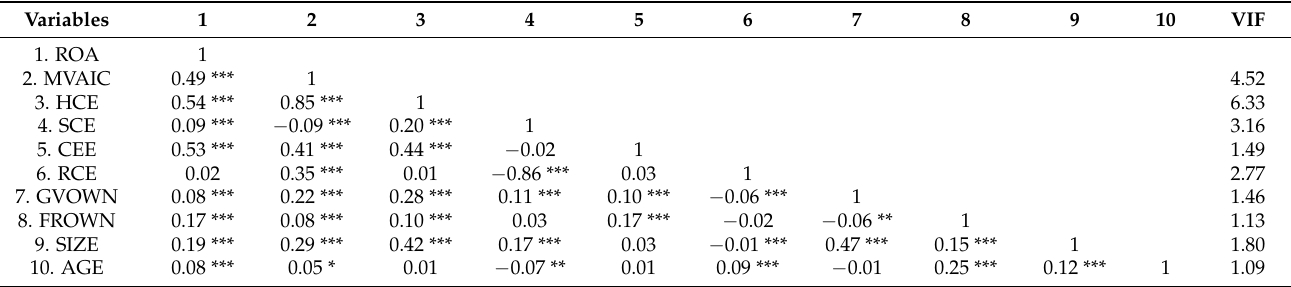
Table 4. Correlation